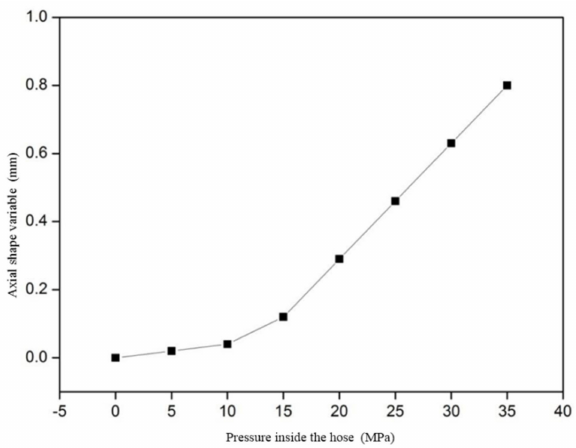
Figure 3. Variation of the axial deformation of the hose with the pressure application process.